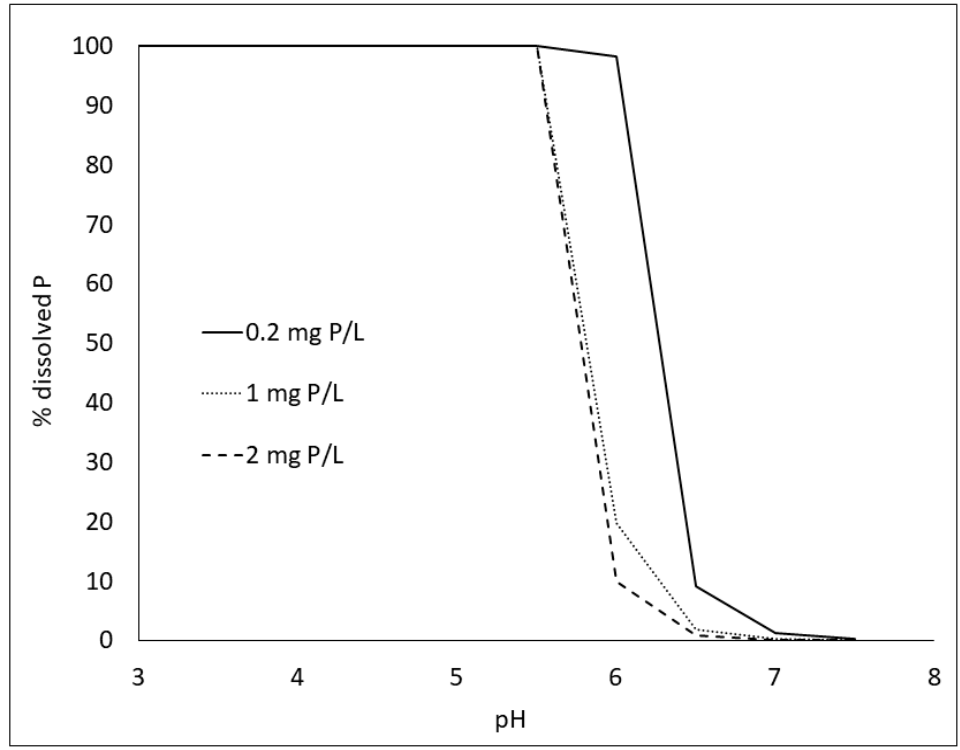
Figure 5. Percent dissolved phosphorus (P) as a function of pH, predicted with speciation modelling software (MINTEQA2; Allison et al. [77]) in a system containing 0.01 M CaCl 2 and varying concentrations of total P.